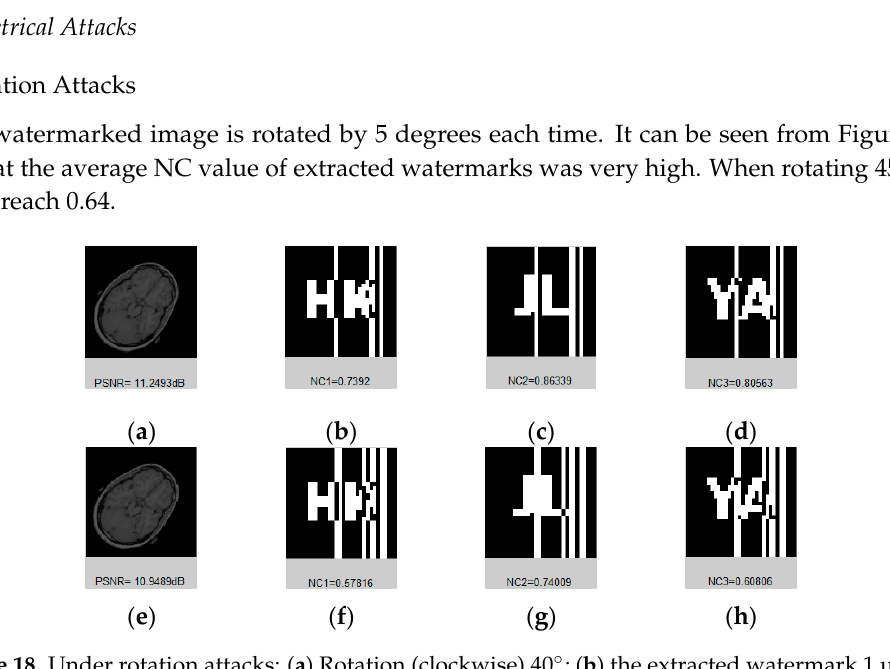
( h ) Figure 19. Under scaling attacks: (a) Scaling factor 0.2; (b) the extracted watermark 1 under scaling factor 0.2; (c) the extracted watermark 2 under scaling factor 0.2; (d) the extracted watermark 3 under scaling factor 0.2; (e) Scaling factor 8.0; (f) the extracted watermark 1 under scaling factor 8.0; (g) the extracted watermark 2 under scaling factor 8.0; (h) the extracted watermark 3 under scaling factor 8.0. Table 7. Data of scaling attacks.